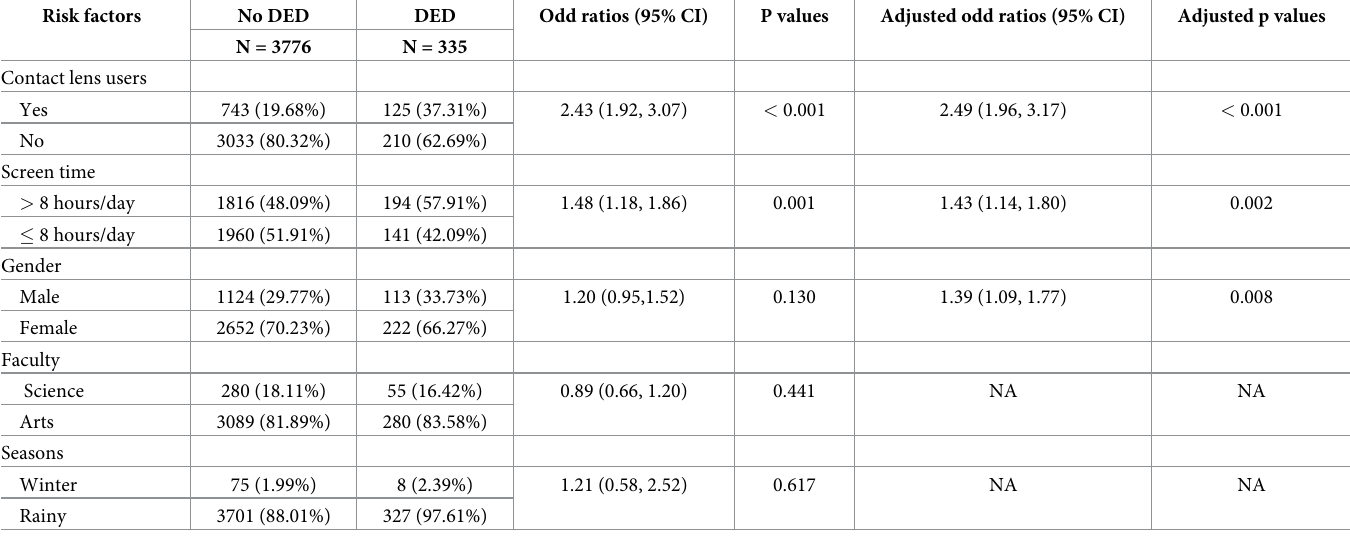
Table 3. Risk factors associated with dry eye disease (DED) in university